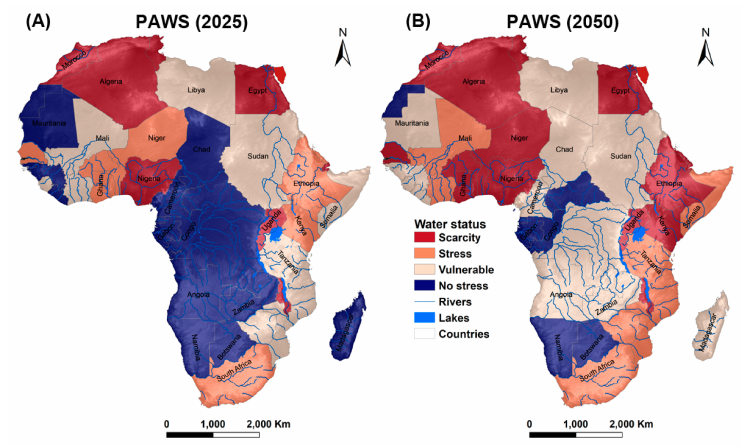
Figure 1. ( A , B ) Projected available water status showing total available renewable freshwater per capita in African countries in the year 2025 ( A ) and 2050 ( B ) [88].